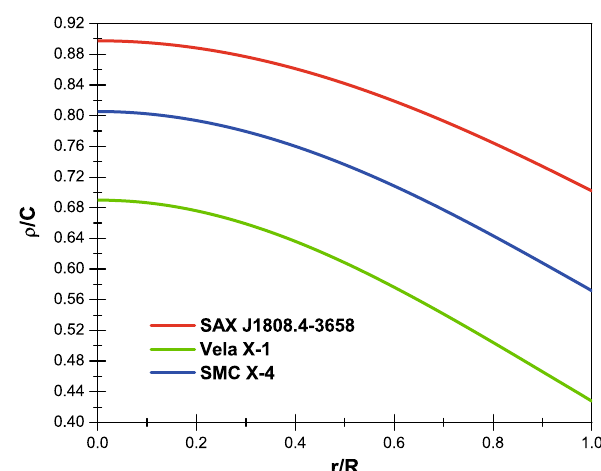
Fig. 5 The dimensionless radial pressure against the fractional radius for α = 0 . 3